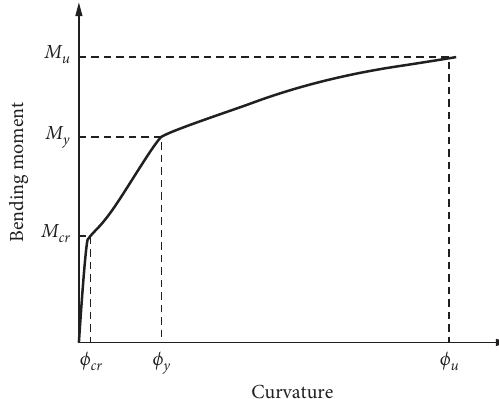
Figure 12: Characteristics of moment-curvature